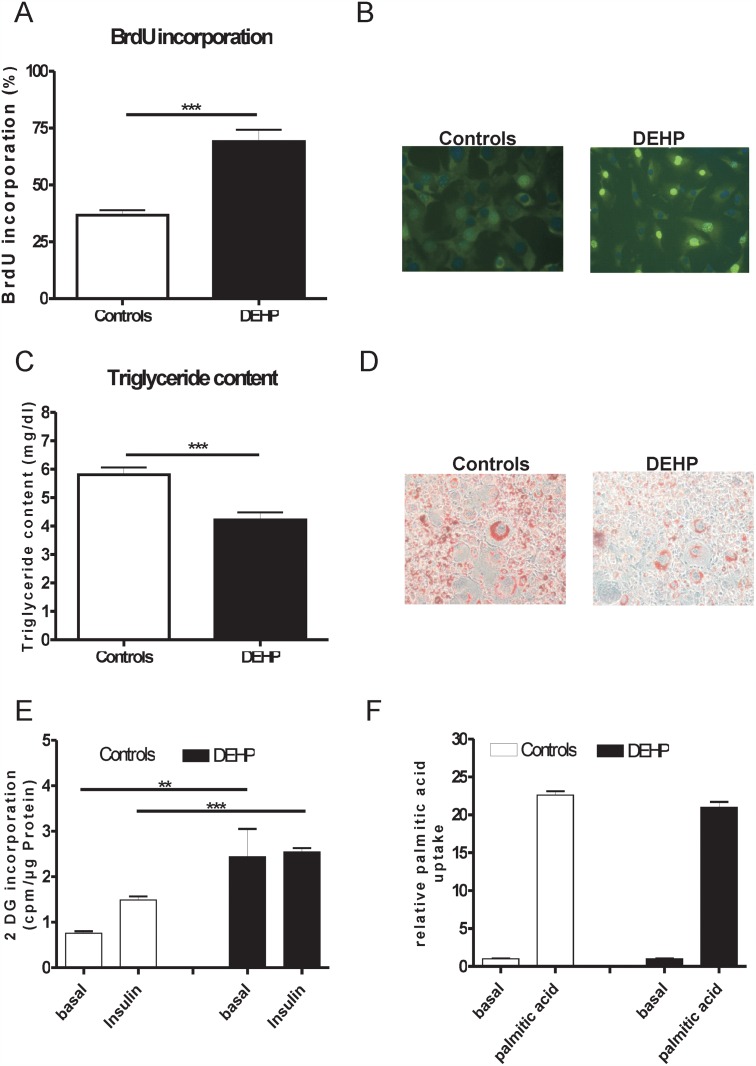
DEHP treatment causes enhanced proliferation rate, reduces lipid content, altered uptake of 2-deoxy-D [14C] glucose and similar palmitic acid uptake into 3T3-L1 adipocytes.
(A) BrdU incorporation in 3T3-L1 adipocytes. BrdU incorporation was assessed in 3T3-L1 preadipocytes grown on glass coverslips. Cells were induced to differentiate for 24 h, and then incubated with 10 μM BrdU for 3 h. (B) BrdU staining- BrdU-labeled cells were visualized using an anti-BrdU antibody and an Alexa Fluor® 488 anti-mouse antibody (C) Triglyceride content in mature 3T3-L1 cells (D) Oil Red O staining of 3T3-L1 adipocytes reveals reduced number of lipid droplet containing cells. 3T3-L1 cells were stained 8 days after induction (magnification 200x). (E) Basal and insulin stimulated uptake of 2-deoxy-D [14C] glucose was significantly increased in 3T3-L1 cells treated with DEHP. (F) Palmitic acid uptake in mature adipocytes with and without DEHP treatment. ** p<0.01, *** p<0.001.